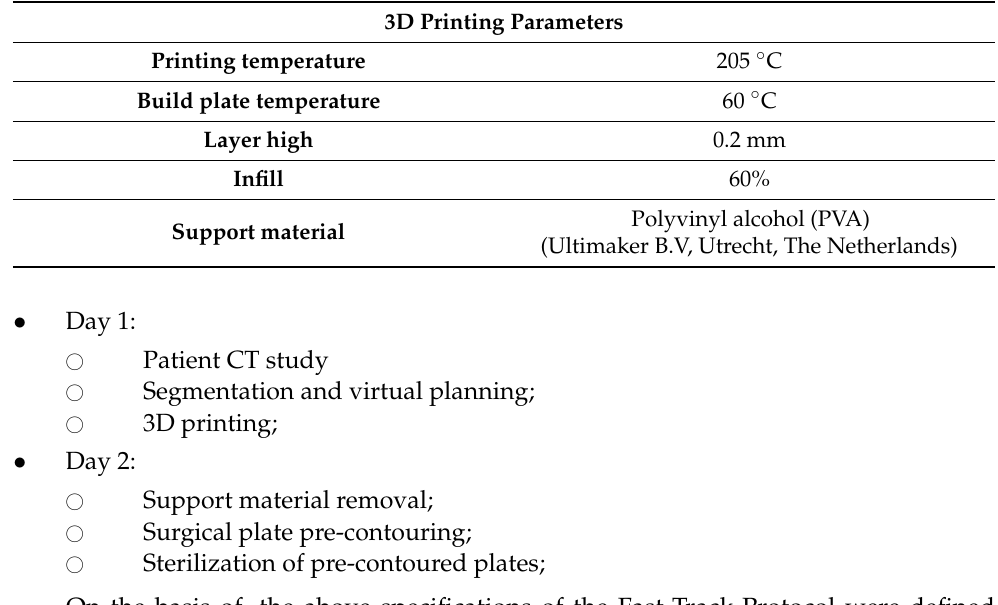
Table 3. 3D printing